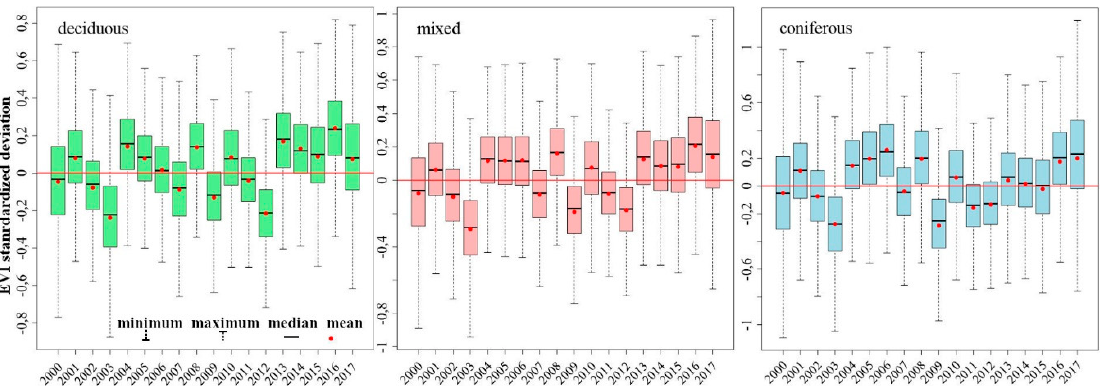
Figure 6. EVI yearly standardized deviation of deciduous, mixed and coniferous forests between 2000 and 2017 based on MODIS MVC images.